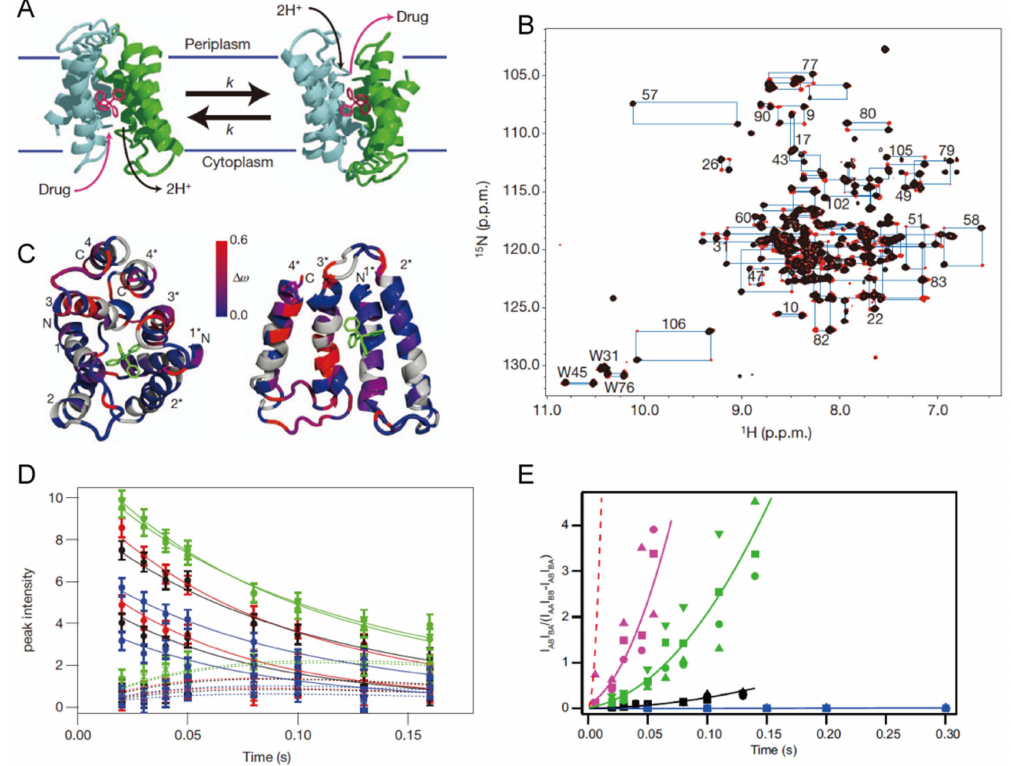
Figure 3. Transportation coupled conformational exchange of EmrE transporter revealed by NMR. ( A ) Proposed transport mechanism of EmrE by antiparallel asymmetrical dimer. The two conformational states adopt an identical structure in opposite orientations with respect to the membrane. Interconversion between the inward-open and outward-open conformations enables EmrE to transport its substrate. ( B ) Overlay of conventional 1 H– 15 N TROSY HSQC spectrum (black) with the TROSY ZZ-exchange spectrum (red, 100 ms mixing time). Blue lines connect exchange peaks and auto-peaks, and residue numbers are indicated. ( C ) Mapping of normalized chemical shift changes ( ∆ ω ) between auto-peaks in the structure of EmrE. ( D ) The global fit of auto- (solid circles) and cross-peak (open circles) intensities in the ZZ-exchange experiment. ( E ) Composite peak ratio analysis of ZZ-exchange data. Significantly different exchange rates for EmrE bound to TPP + (black) and the other slow-exchanging derivatives, EtTPP + (magenta), MBTPP + (green), and DPhTPP + (blue). Global fits are depicted with solid lines, along with the experimental data points. The dashed red line corresponds to a simulation of the composite peak ratio of fast-exchanging MeTPP + using the rate of conformational interconversion determined via line shape analysis. This figure was adapted from [86] with